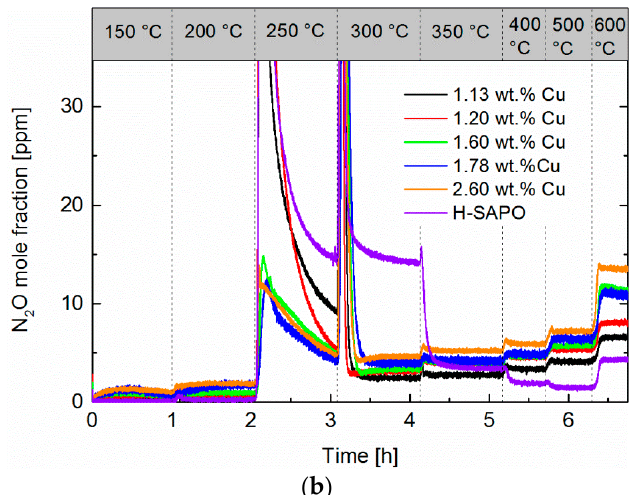
Figure 9. Fast SCR transient outlet NO x ( a ) and N 2 O ( b ). Inlet: 400 ppm NH 3 , 200 ppm NO, 200 ppm NO 2 , 8% O 2 , 5% H 2 O.